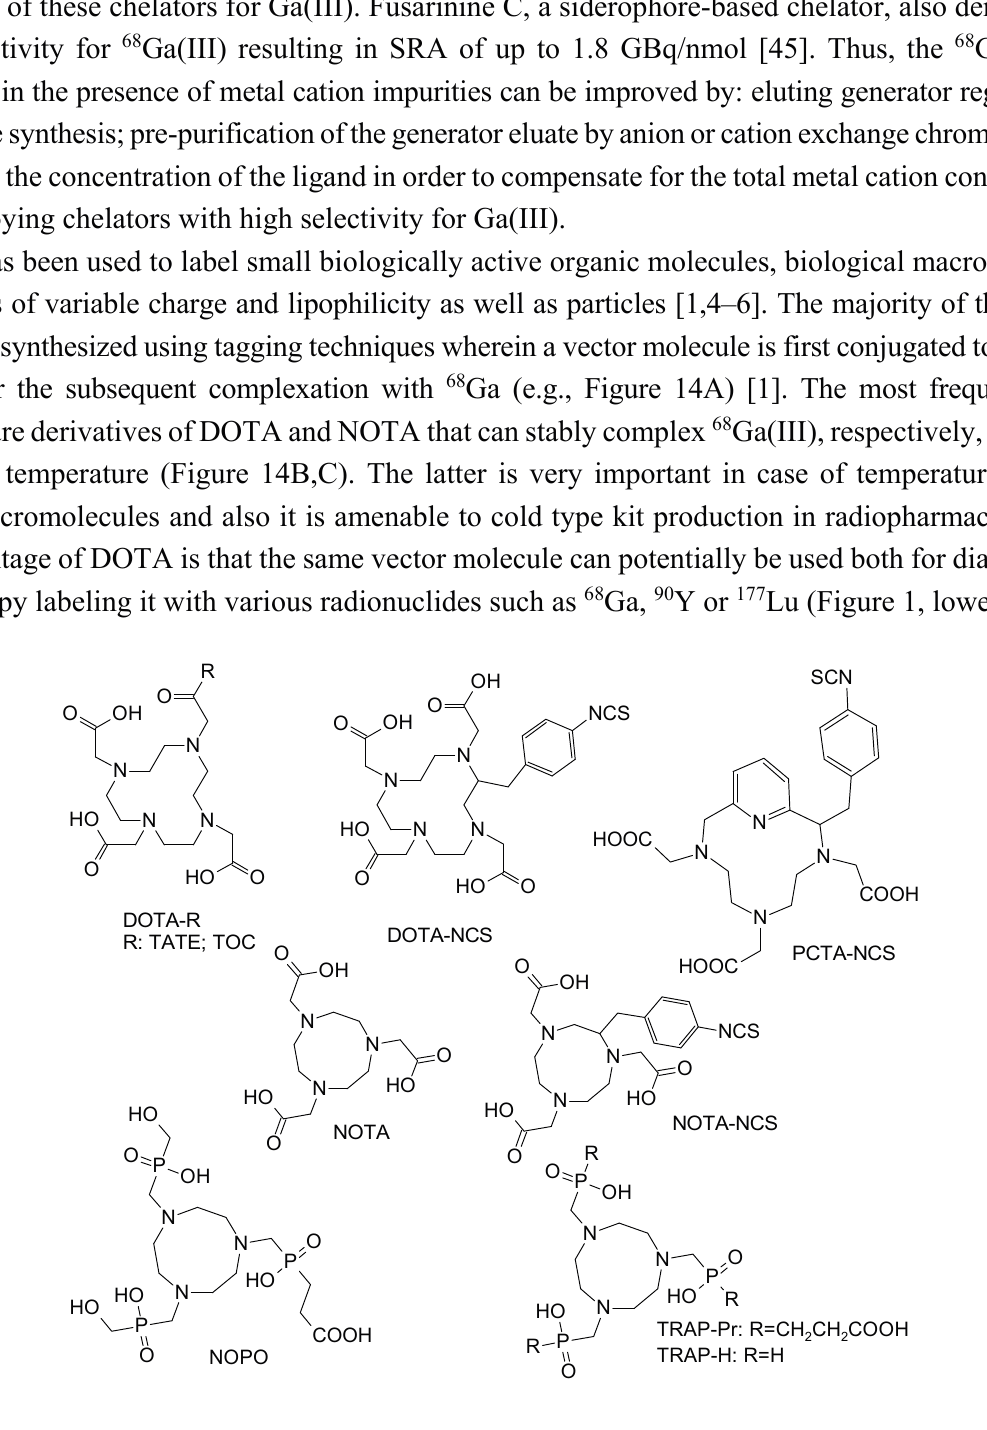
Figure 13. Chemical structures of example macrocyclic chelators and their derivatives that were studied in the competitive complexation reaction with various metal